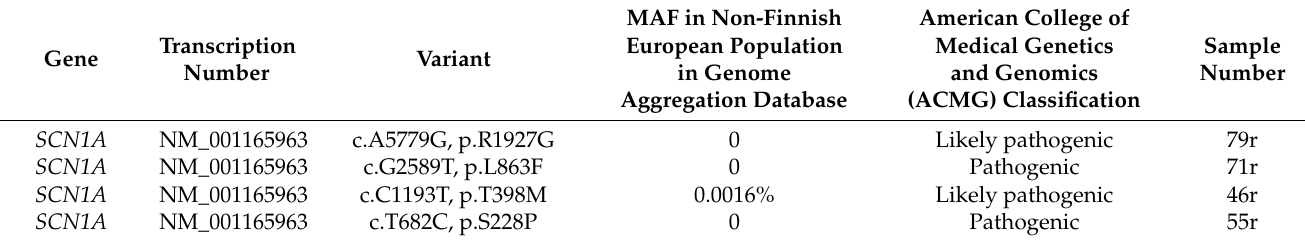
Table 2. Identified SCN1A variants of 21 ALS